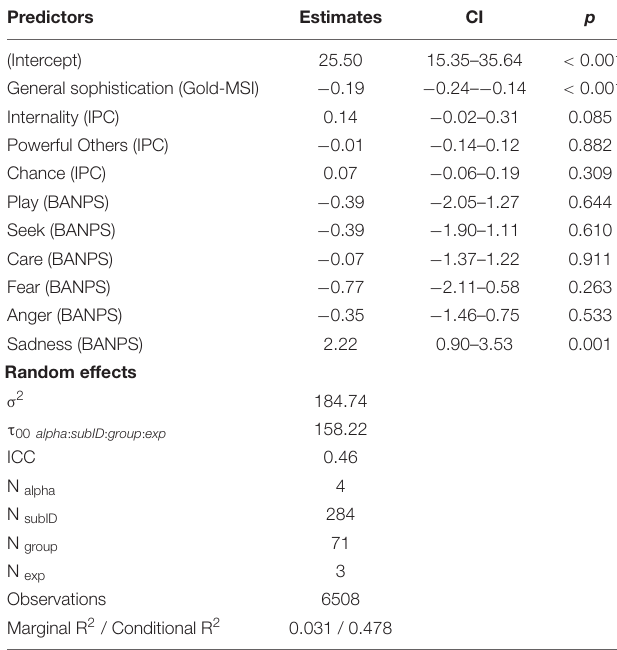
TABLE 4 | Person-level predictors of individuals’ SD asynchrony differences from the